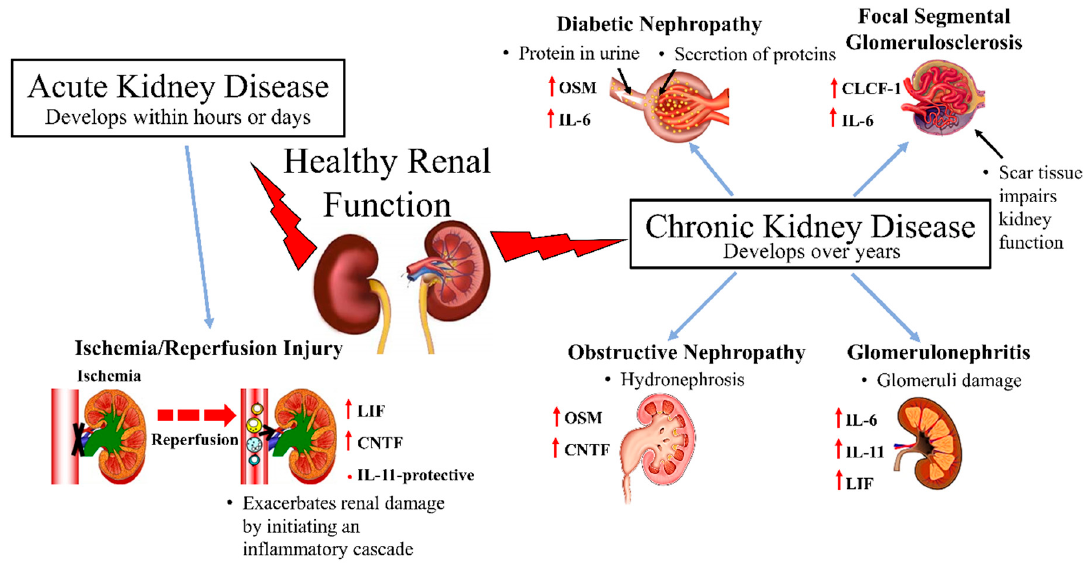
Figure 2. A diagrammatic overview of IL-6 cytokine family members’ relationship to various kidney diseases.